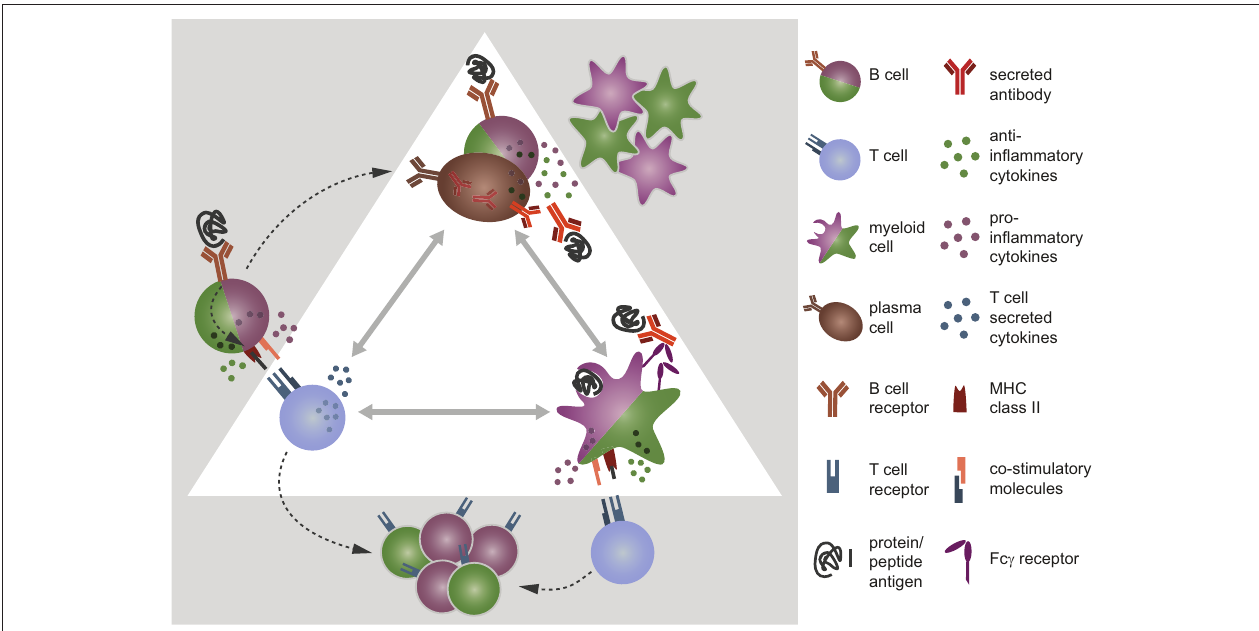
FIGURE 1 | B cells, T cells, and myeloid cells shape each other’s immune response via direct interaction and/or secretion of cytokines. (A) B cells encounter protein antigens specifically via their B cell receptor and present linearized peptides bound to the major histocompatibility complex (MHC) class II to T cells. Thereby, they act as efficient antigen-presenting cells and control the differentiation of T cells by the density of co-stimulatory molecules on their cell surface and the cytokine milieu they provide. In turn, this interaction fosters (B) the differentiation of B cells into antibody-producing plasma cells and memory B cells. B and plasma cells secrete pro- and anti-inflammatory cytokines, which affect the expression of co-stimulatory molecules and the production of chemokines/cytokines by myeloid antigen-presenting cells. Vice versa, myeloid cells have an impact on B cell activity through the secretion of distinct cytokines and chemokines. (C) Myeloid antigen-presenting cells, such as monocytes, macrophages, and dendritic cells internalize antigen randomly or opsonized antigen specifically via Fc γ receptors, process them, and present the linearized peptides via MHC class II to T cells. They are able to induce both pro- and anti-inflammatory T cells, controlled by the expression density of co-stimulatory molecules on myeloid APC and their distinct secretion of